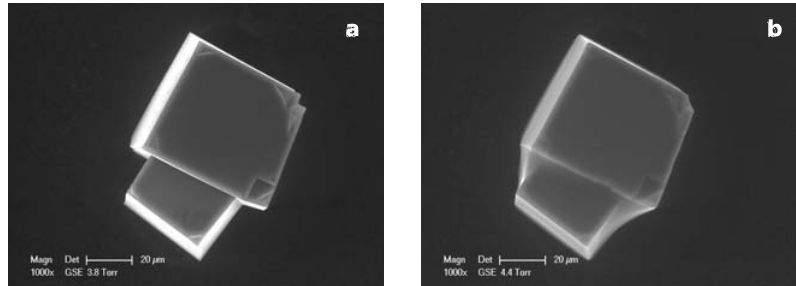
Fig. 4 Capillary condensation of water on NaCl crystal.